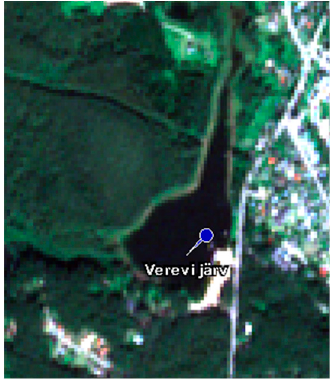
Figure A2. S2 MSI image of Verevi from 28th of August 2016.